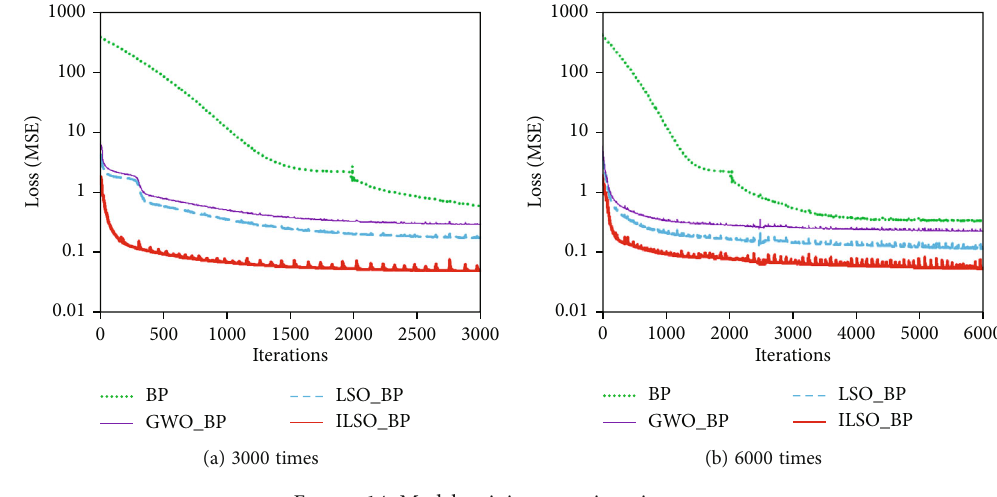
Figure 14: Model training error iteration Table 4: Final training error vs. test error for four algorithms (number of iterations is 3000).